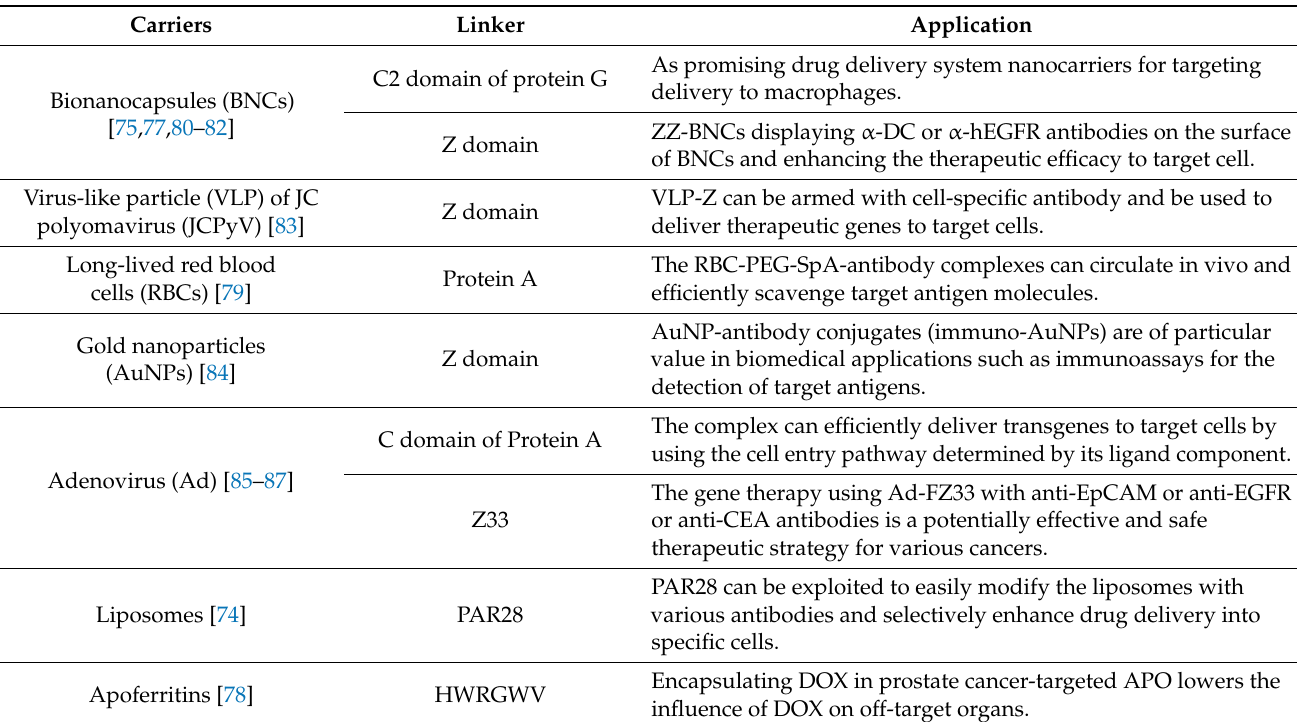
Table 4. Different active targeting drug delivery carriers and their